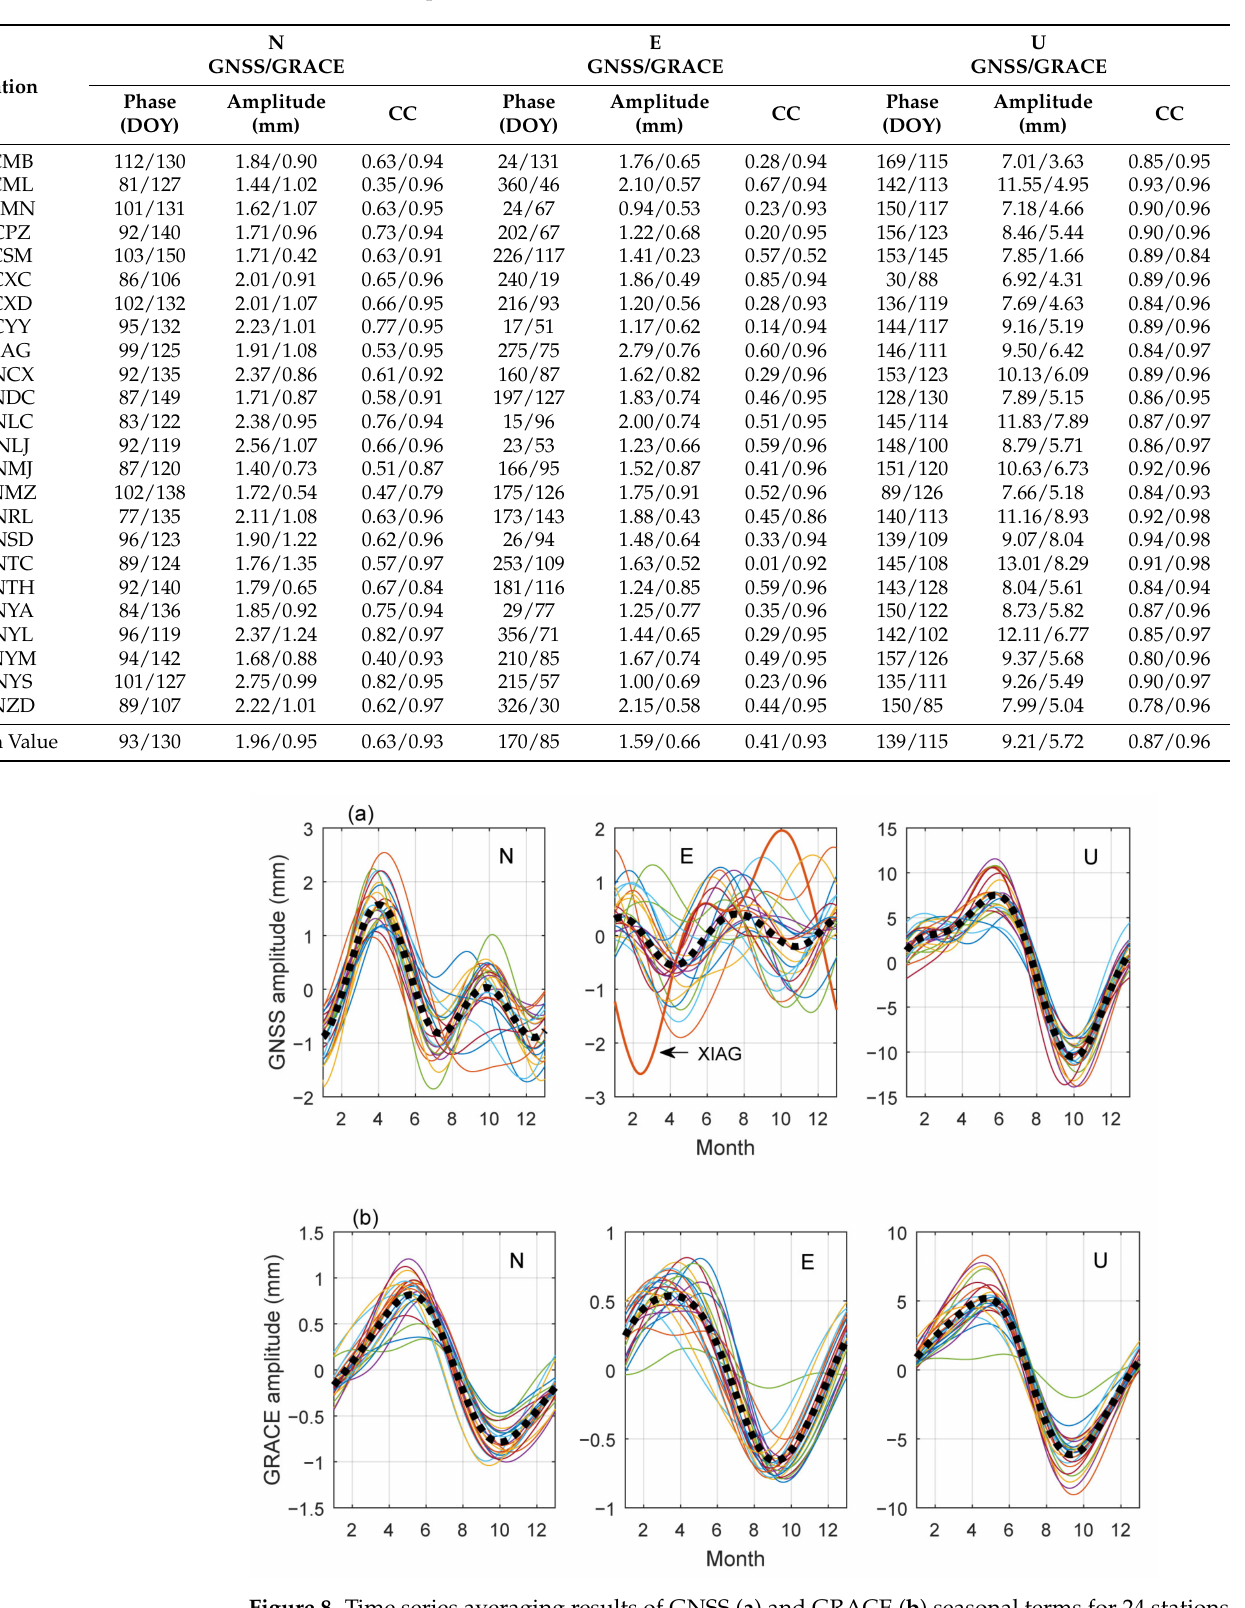
Figure 8. Time series averaging results of GNSS ( a ) and GRACE ( b ) seasonal terms for 24 stations. (The colored lines are the average seasonal terms of each station, and the black dashed lines are the average seasonal terms of the 24 stations